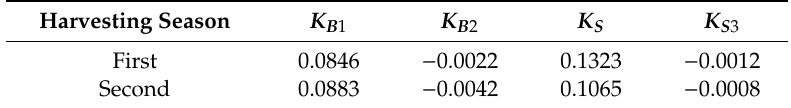
Table 3. Sets of calculated unknowns calculated separately for both harvesting seasons (“two-fit” case).